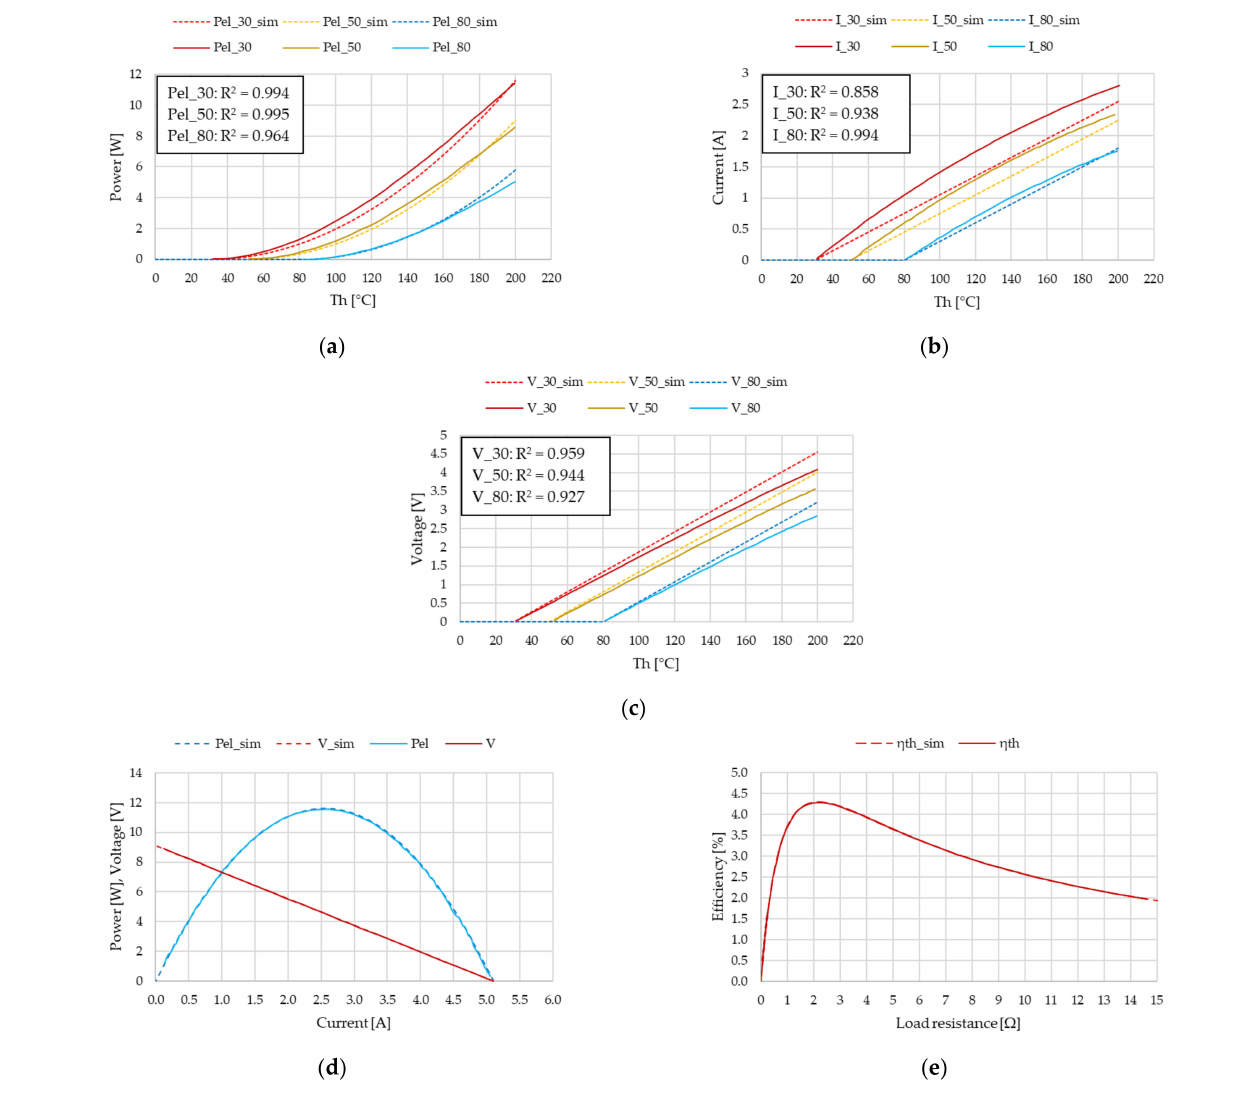
Figure 4. Manufacturer data compared to calculated data at matched load resistance conditions for TGM-199-1.4-0.8: ( a ) Module power; ( b ) module current; ( c ) module voltage; ( d ) module power and voltage with respect to current; and ( e ) module